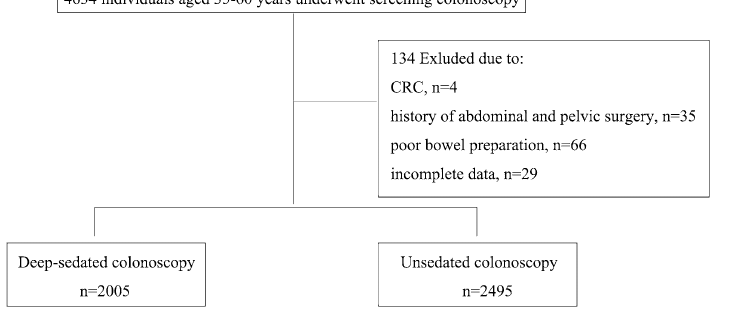
Figure 1. Study subject flow chart.